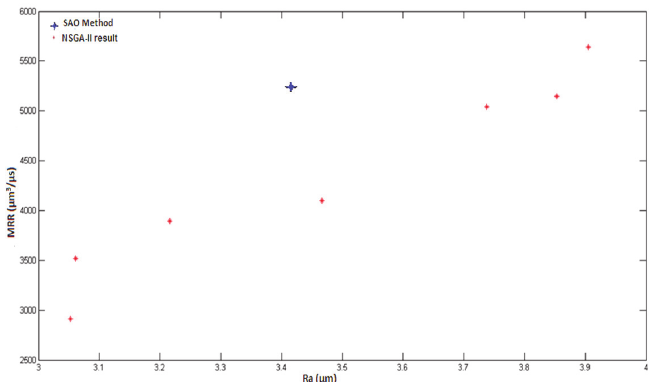
Fig. 4. Pareto optimal front and comparison of result for AWJM